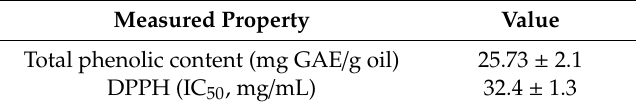
Table 6. Total phenolic content and antioxidant activity of avocado